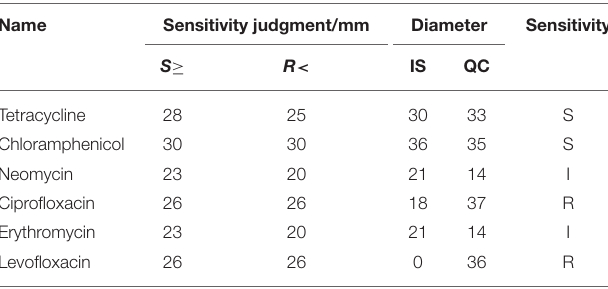
TABLE 1 | The results of antimicrobial susceptibility